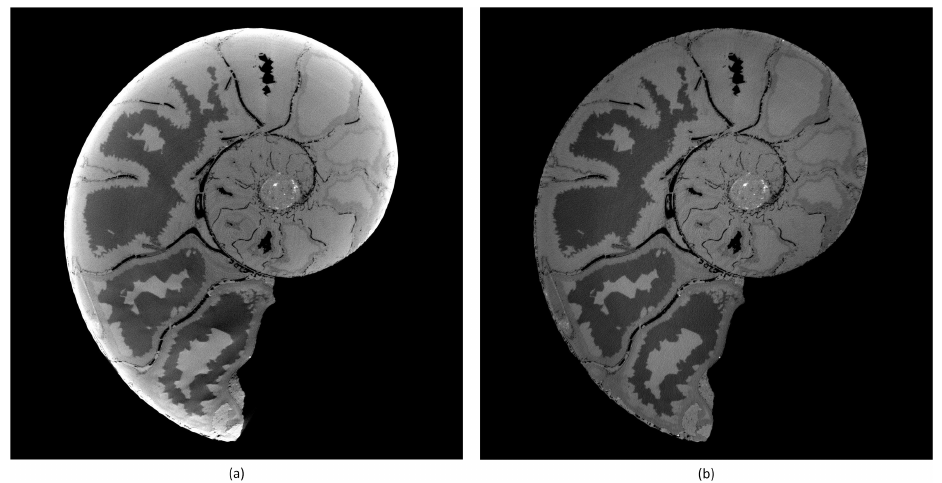
Figure 3. Tomogram of an ammonit. Left ( a ) without BHC. Right ( b ) with BHC. Parameters: a = 1.0, b = 1.0, c = 3.0.